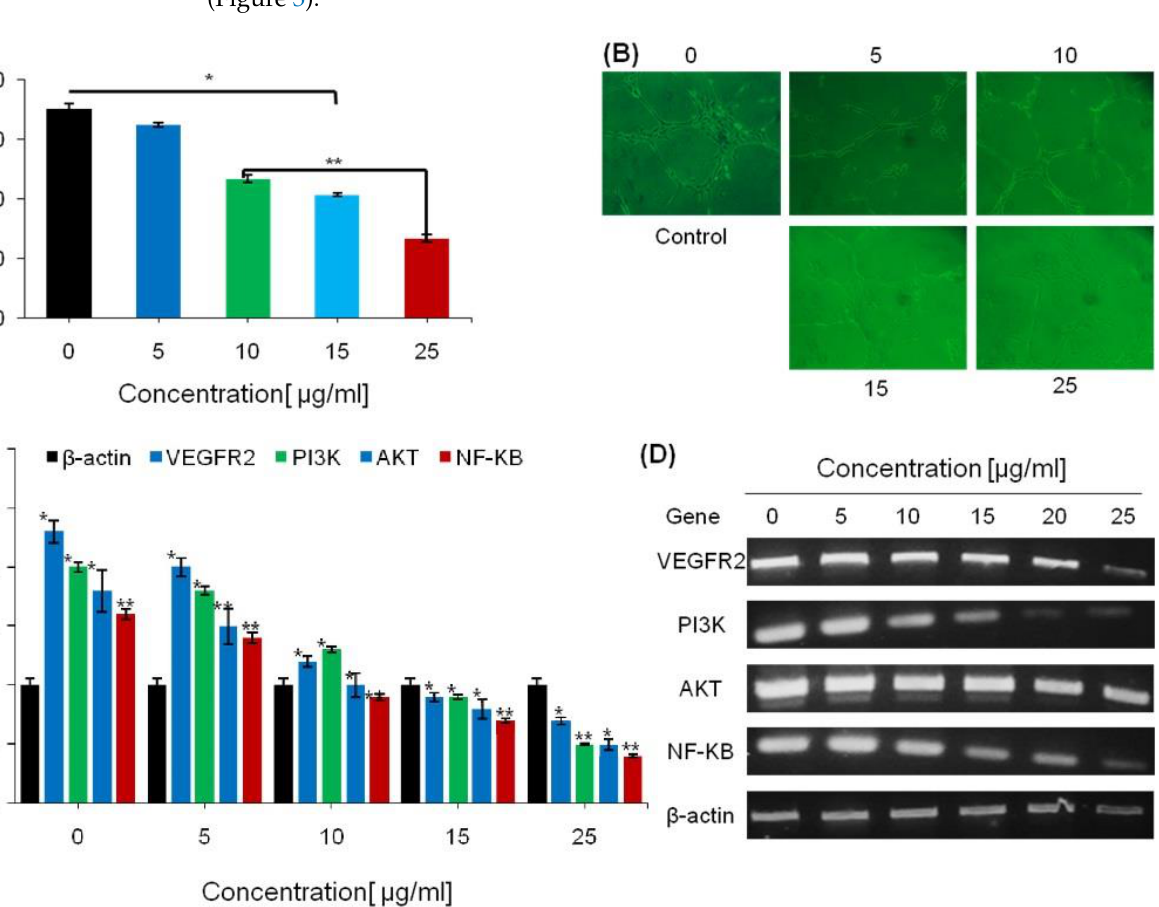
Figure 3. Effects of saponins on angiogenesis suppression. ( A ) HUVEC proliferation and formation of tubes on a Matrigel was calculated and presented as the total tube length in control and treated groups. ( B ) Photographs of HUVEC proliferation and tube formation in the control and treated groups. ( C ) The effect of saponins on the expression of angiogenesis-related genes determined by RT-PCR. ( D ) Gel electrophoresis of the PCR products from the treated and control cells. The data are shown as the mean ± SEM of three separate experiments. * = p < 0.01 and ** = p < 0.001 compared with the